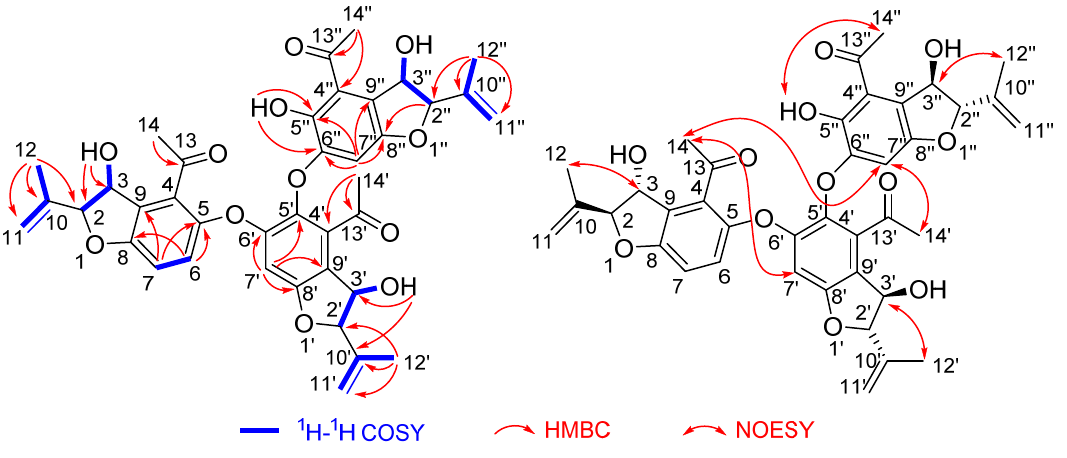
Figure 3. Key 2D NMR correlations for 3 .